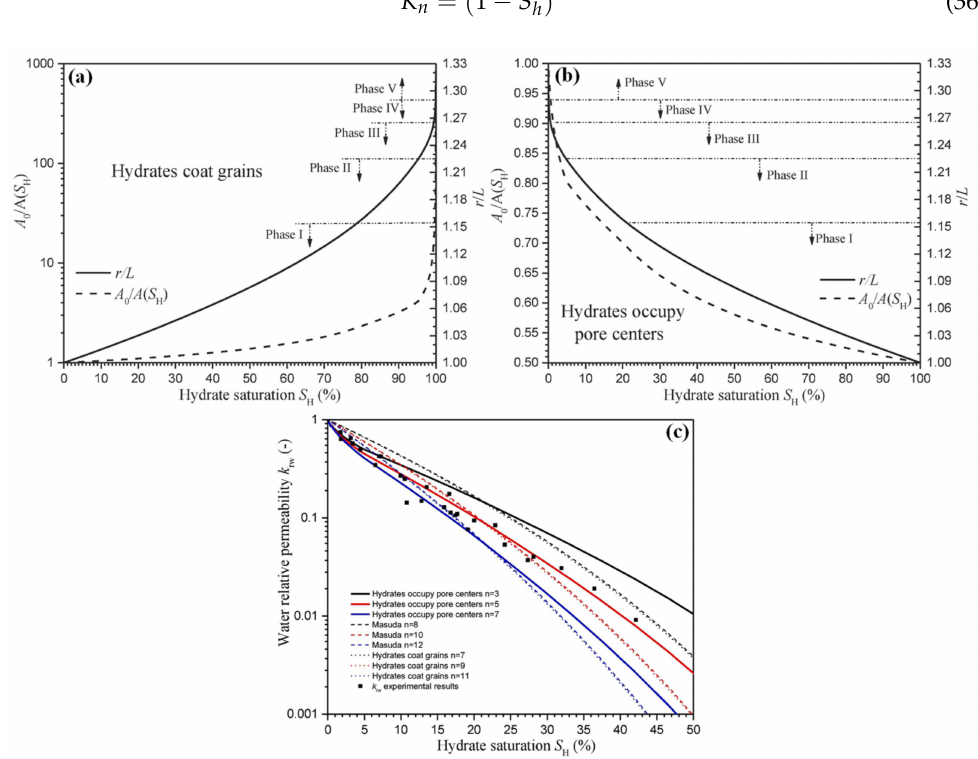
Figure 14. The relationship between S h , A 0 / A ( S h ), and r / L in the model of ( a ) hydrates coating grain surfaces and ( b ) hydrates occupying pore centers; ( c ) experimental data and the K n - S h relationship reprinted from [101] with permission from